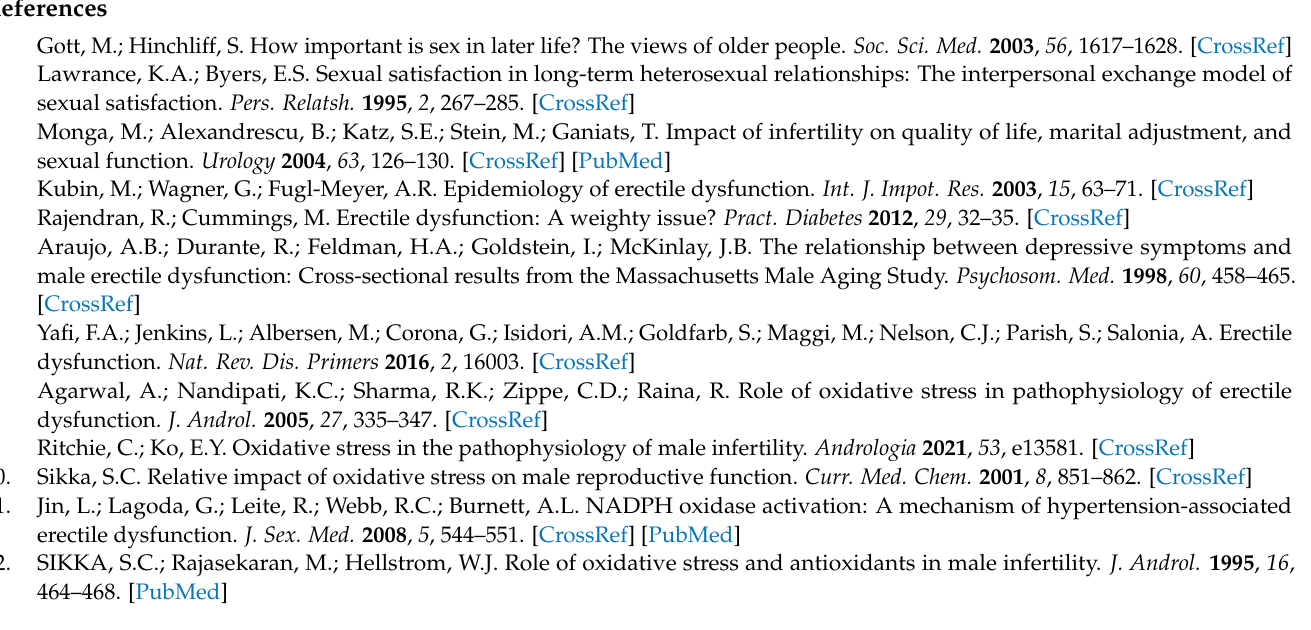
pudica Linn. Table S2: Details of bonding interactions between phosphodiesterase type 5 enzyme with selected bioactive molecules and standard drug. Figure S1: Per-residue energy decomposition of PDE5-APO (Black), PDE5-BUF (Green), PDE5-STI (Yellow), PDE5-ISV (Blue), PDE5-APT (Red) and PDE5-STD drug Sildenafil (Brown). Refs [72–78] are cited in Supplementary